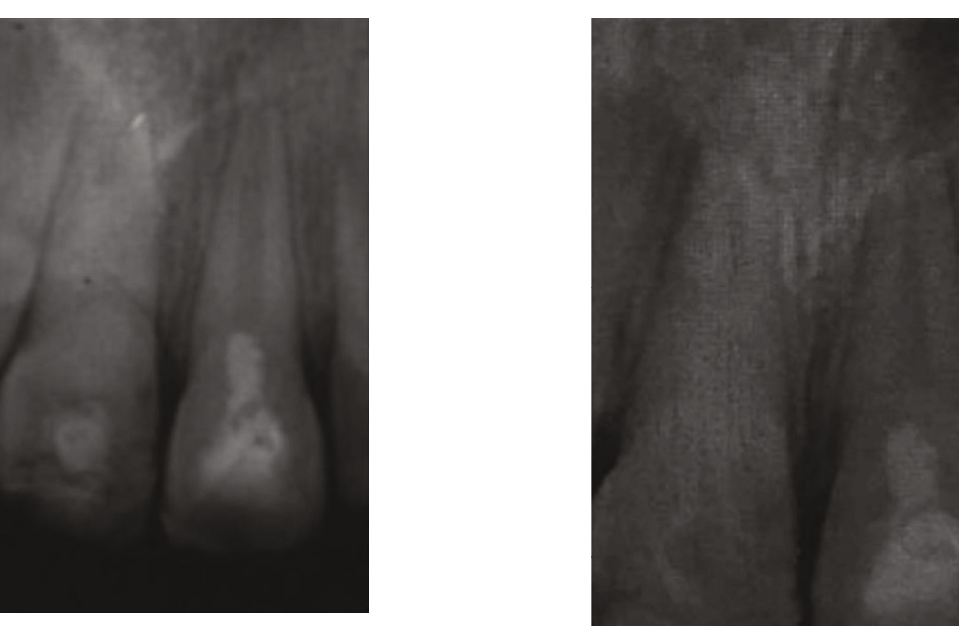
Figure 4: Retroalveolar radiograph showing capping of the blood clot with MTA. Figure 5: 3-month follow-up radiograph after revascularization: beginning of root edi fi cation on 21.